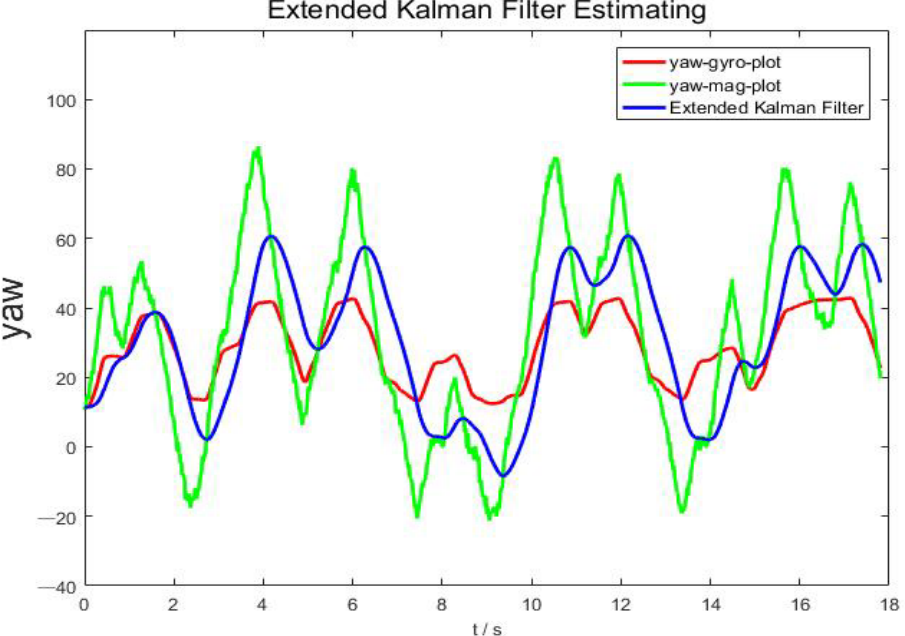
Figure 17. MPU9250 dynamic result after EKF data fusion.